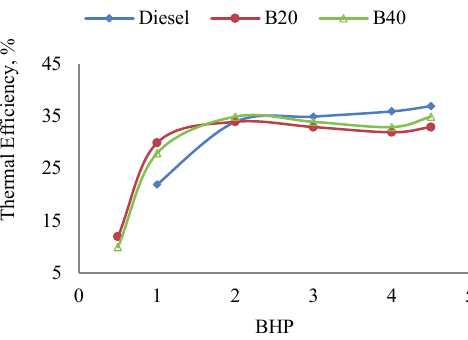
Fig. 9. Performance Characteristics between BHP vs. Thermal Efficiency for Diesel and Biodiesel Blends.